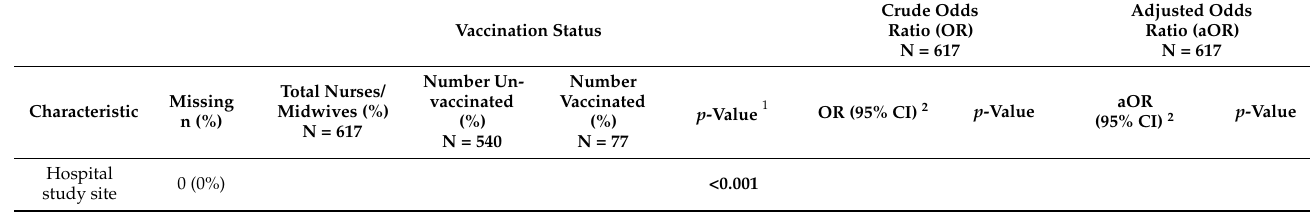
Table 2. Factors associated with early COVID-19 uptake among nurses and midwives in the multi- variable analysis, Georgia, March–July